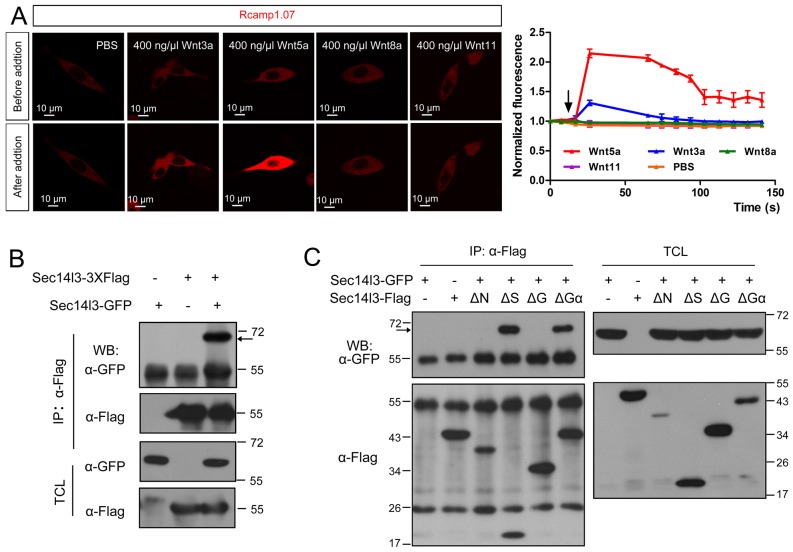
Sec14l3 can self-assemble into oligomers.(A) Living imaging of calcium release upon Wnt stimulation in PC3 cells. PC3 cells were transfected with calcium indicator plasmid Rcamp1.07 and then starved for 400 ng/μl Wnt3a, Wnt5a, Wnt8a and Wnt11 stimulation individually. PBS serves as negative control. The arrow indicates the time point when Wnt is added. Scale bar, 10 μm. (B) Sec14l3 can be assembled into an oligomer in HEK293T cells. (C) Sec14l3 oligomer formation is mediated by its CARL-TRIO and GOLD domains.